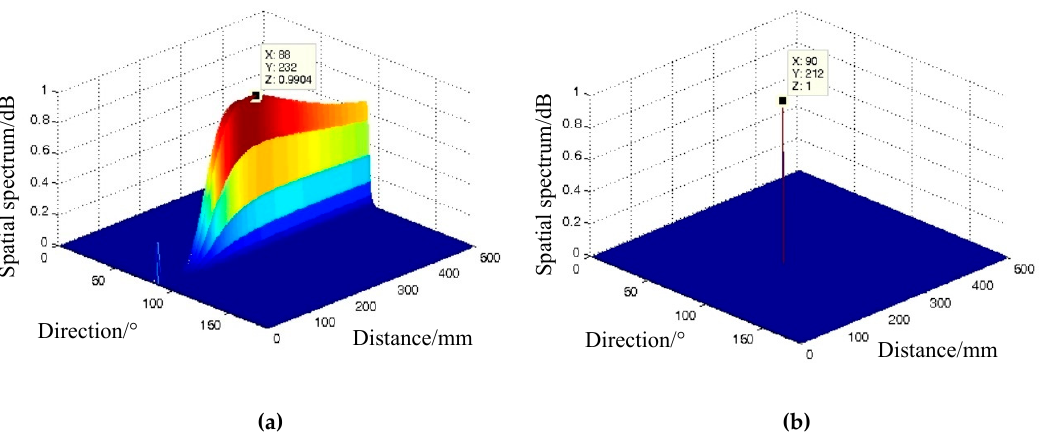
Figure 5. Spatial spectrum estimated by (a) standard 2D-MUSIC and (b) 2D-MUSIC after error calibration